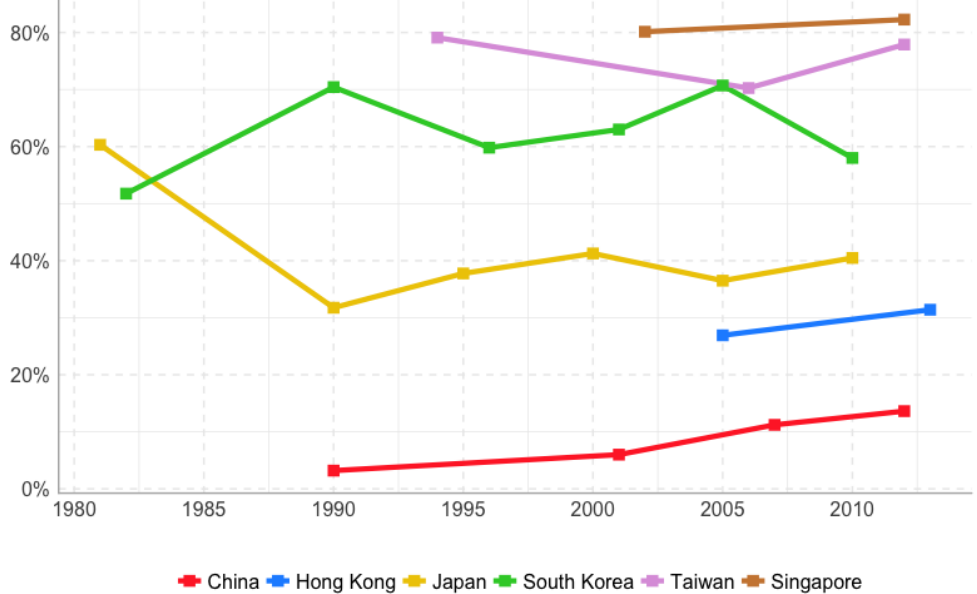
Figure 1. Percentage of respondents with religious affiliation in East Asian societies (World Values Surveys, weighted).